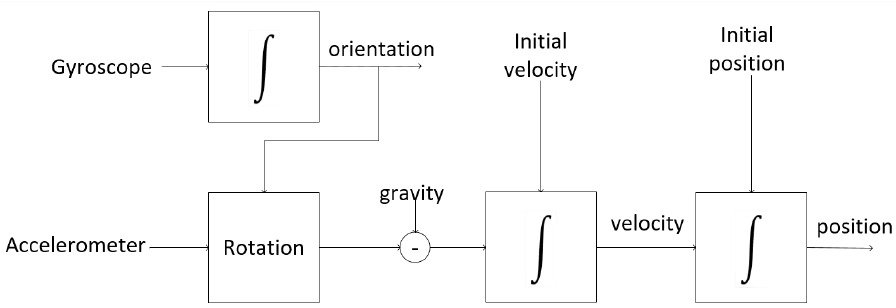
Figure 7. Strapdown navigation system.